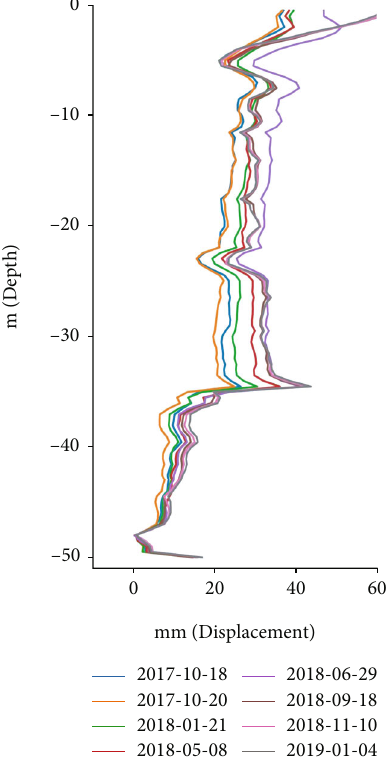
Figure 6: Multi-day cumulative displacement-depth curve of ZK4- 1